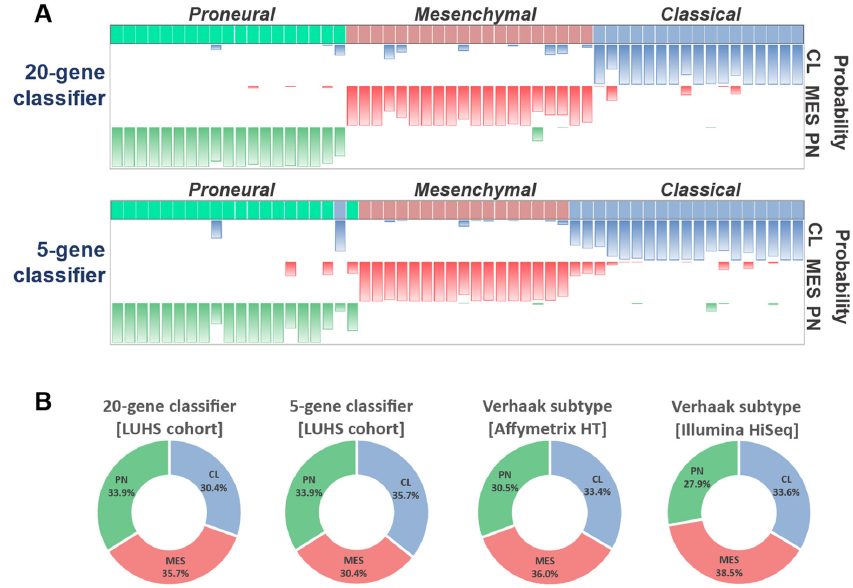
Figure 5. ( A ) LUHS cohort classification comparison between 20-gene and five-gene classification models. Green, red, and blue colors indicate PN, MES, and CL subtypes, correspondingly. The height of each color bar represents the calculated subtype probability for each sample. ( B ) Comparison of subtype proportions in the LUHS cohort was classified by applying 20-gene and five-gene models and TCGA cohorts classified by Verhaark.